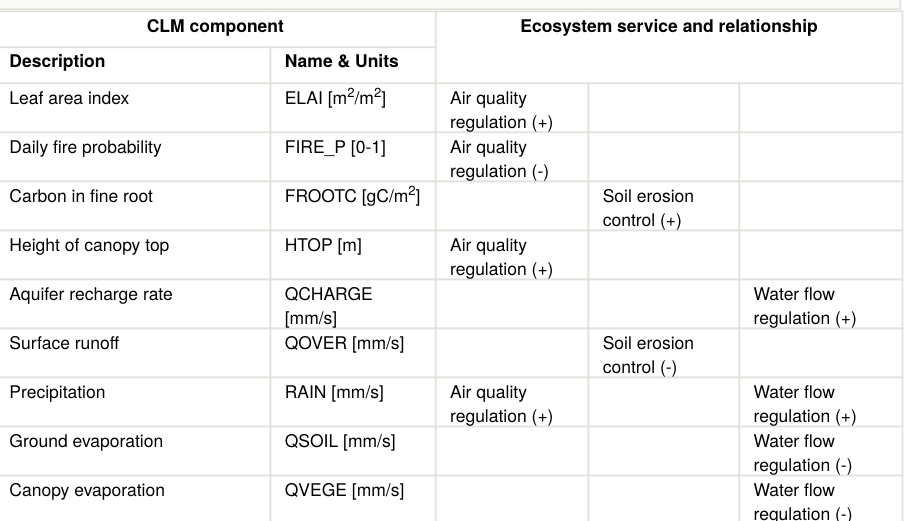
Bio-physical variables from the CLM (proxies for ecosystem functions, EF, or ecosystem processes, EP) and related ecosystem services (ES). Positive relationships between EF / EP and ES are indicated with ‘+’, negative relationships with